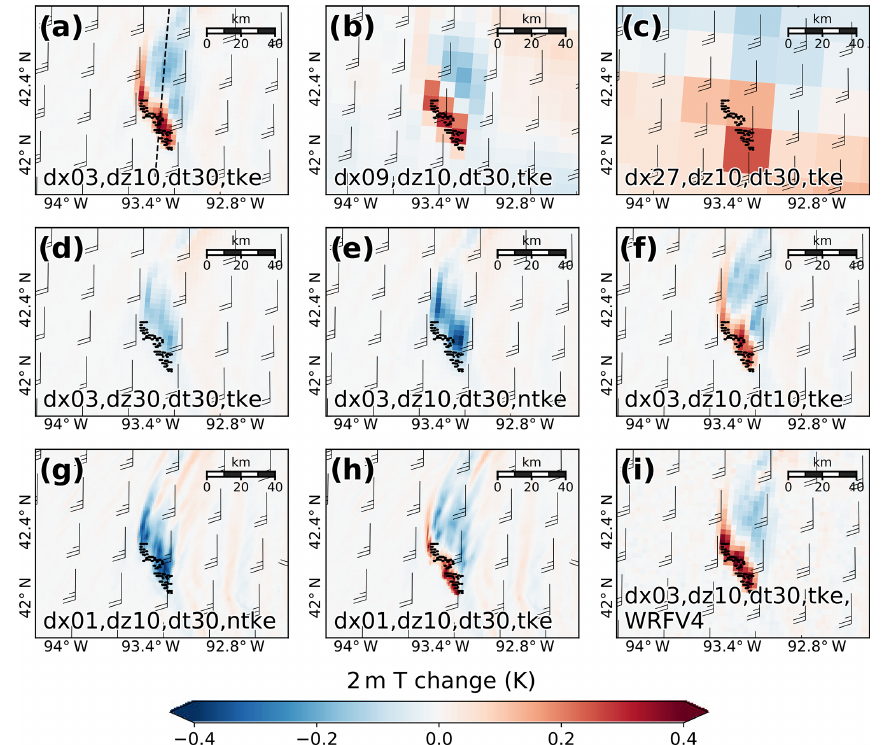
Figure 10. Near-surface (2m) temperature ( T ) changes resulting from the presence of the wind farm in the tested simulations on 26 August 02:00UTC (25 August 21:00LT). The 80m wind barbs from the wind farm simulation are plotted in knots every 27km, regardless of horizontal resolution. The dashed line in panel (a) denotes the location of the vertical cross section in Fig. 11. Panels are cropped to the same region around the wind farm despite certain configurations having varying simulation domains depending on horizontal